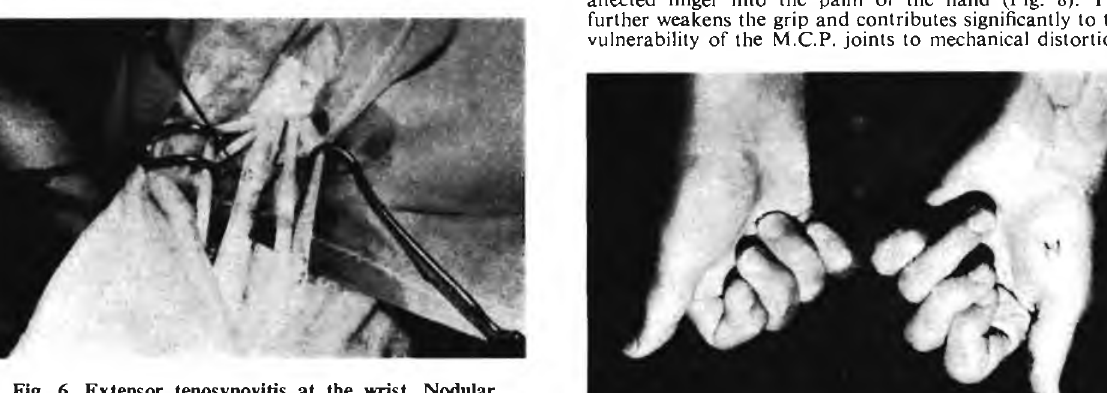
Fig. 6. Extensor tenosynovitis at the wrist. Nodular degeneration of the tendon is shown. FLEXOR TENOSYNOV ITIS AT TH E W RIST Fig. 8. Flexor tenosynovitis of the hand and fingers causing inability to curl the affected fingers into full flexion.